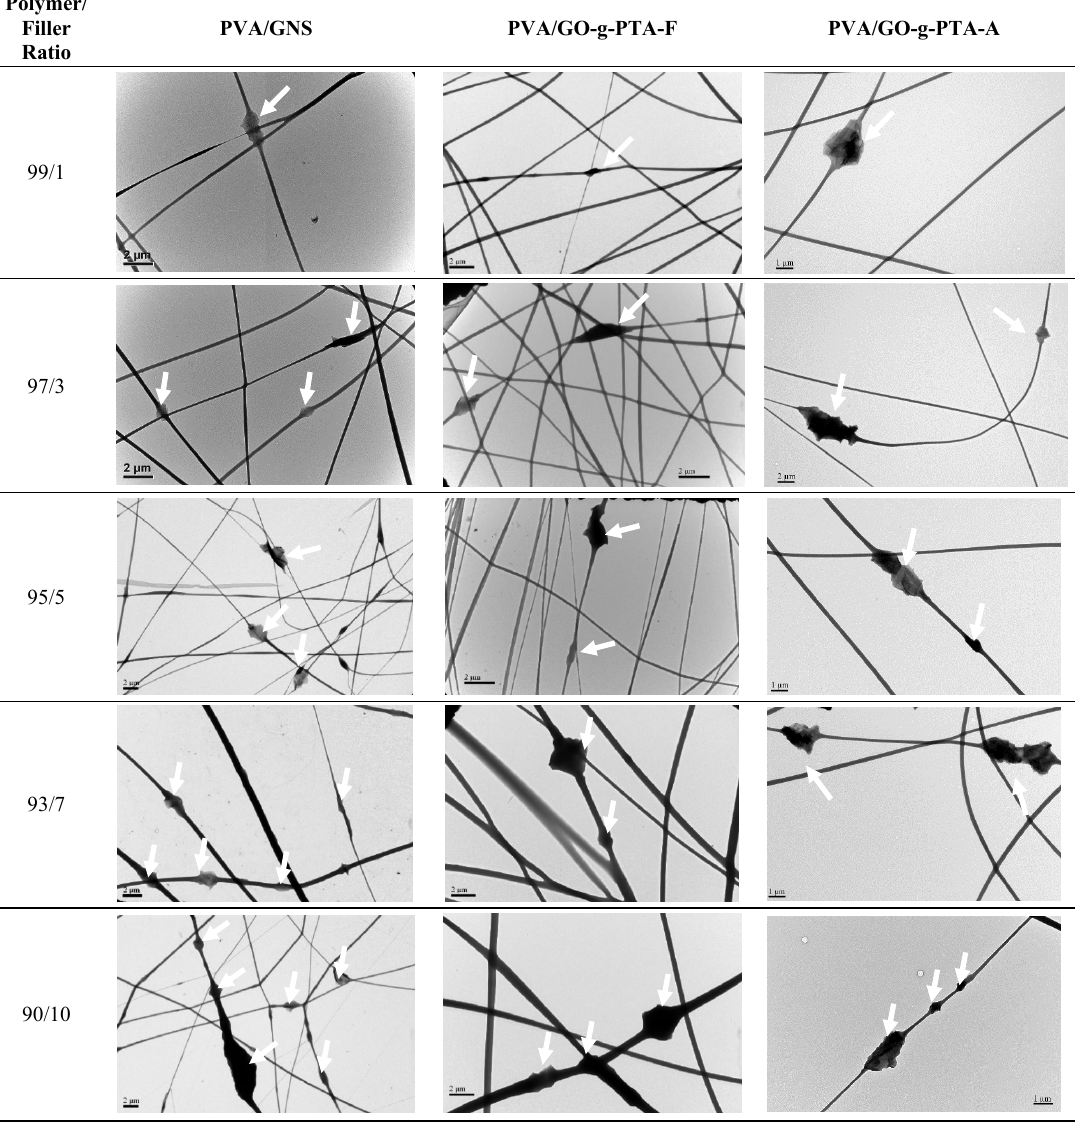
Figure 7. TEM images of electrospun PVA composite nanofibers filled with various amounts of GO, GO-g-PTA-F, and GO-g-PTA-A. The positions of GO, GO-g-PTA-F, and GO-g-PTA-A are indicated by the arrows.